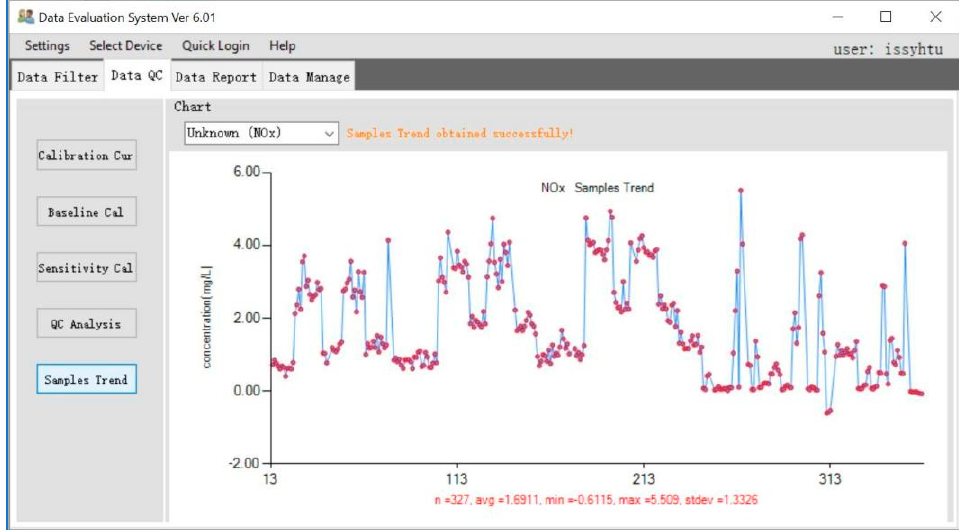
Figure 13. Sensitivity calibration of the sample data.